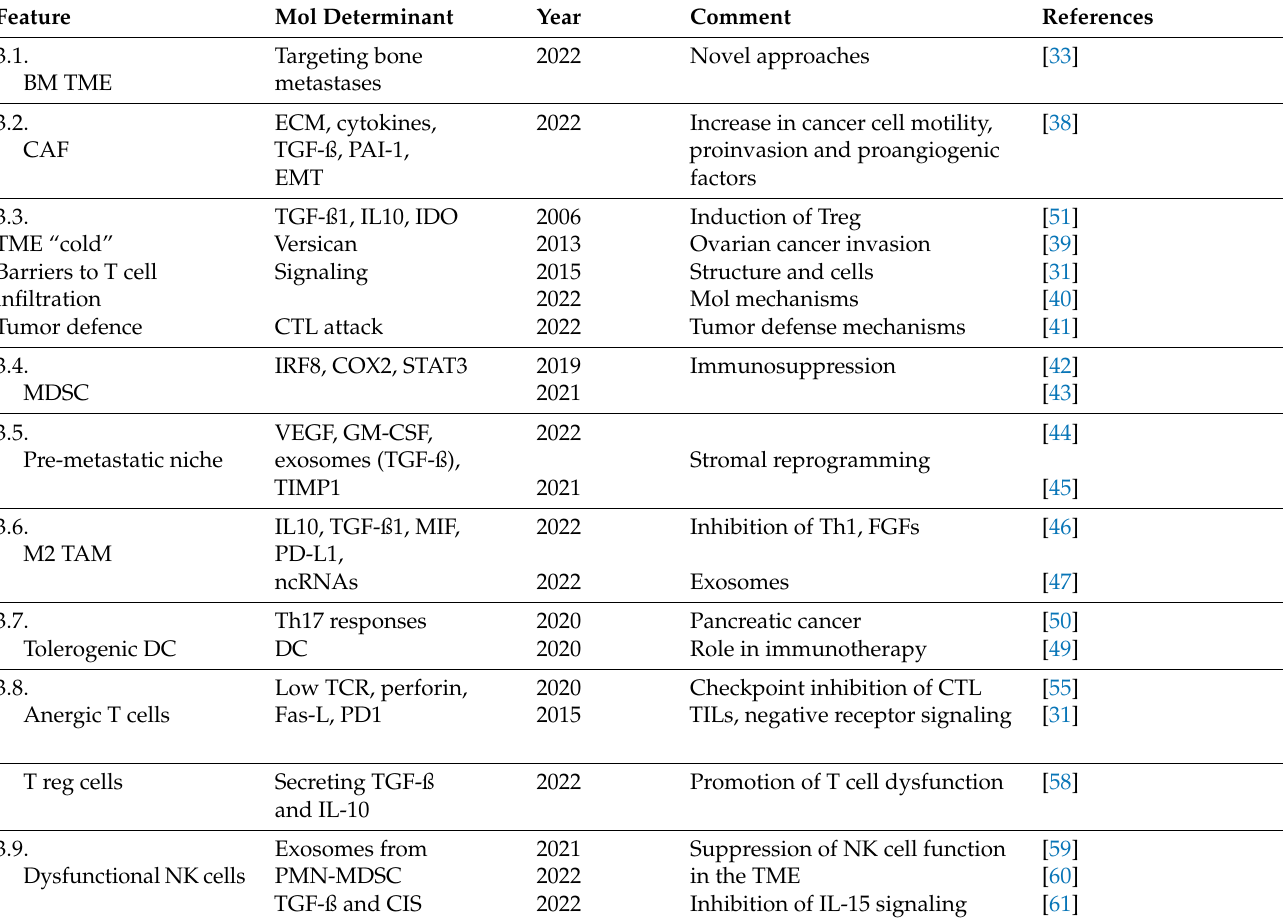
Table 2 lists the topics discussed in chapter 3. Table 2. The tumor